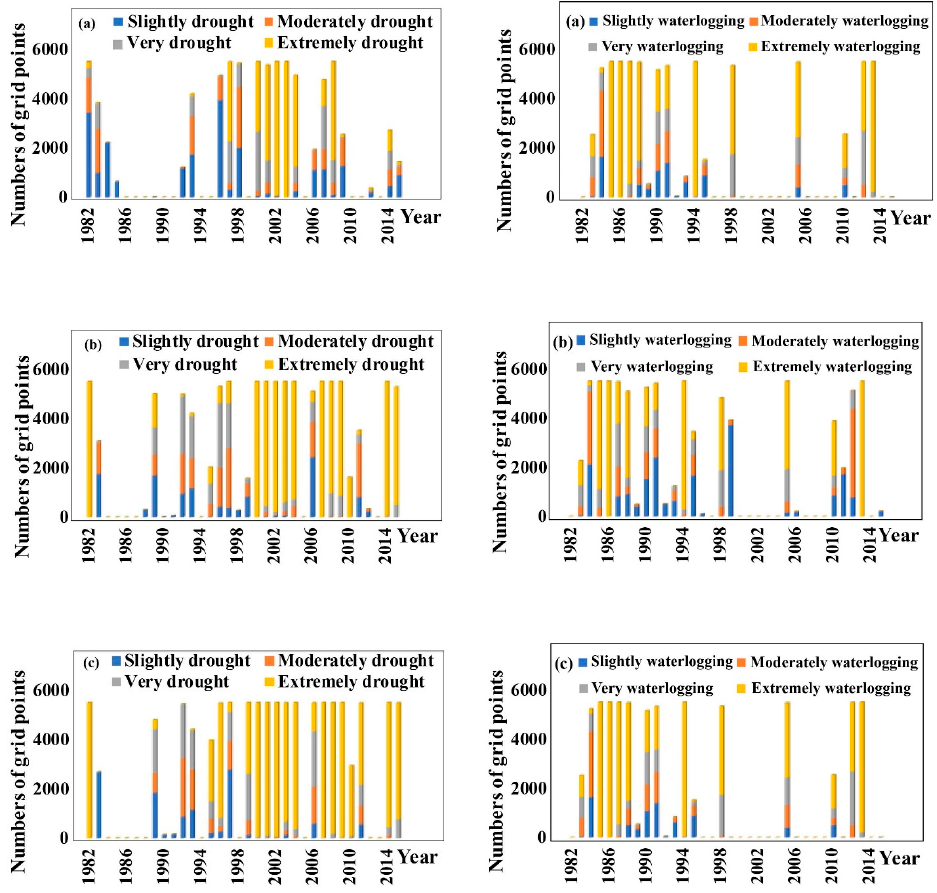
Figure 7. Variations of the regional average values of different drought and waterlogging conditions at different stages for maize based on CDWI from 1982 to 2015 in Midwestern Jilin Province. ( a – c ) represent the stages of emergence-tasseling stage, tasseling-milky maturity, and milky maturity- mature, respectively.